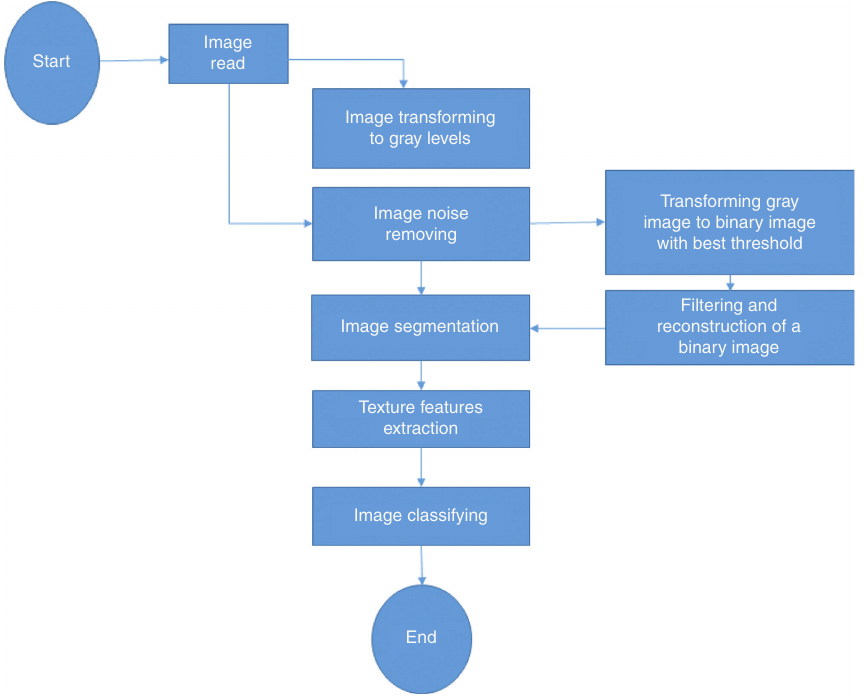
Figure 4: Flowchart of the Image Processing and Analysis Based on Texture